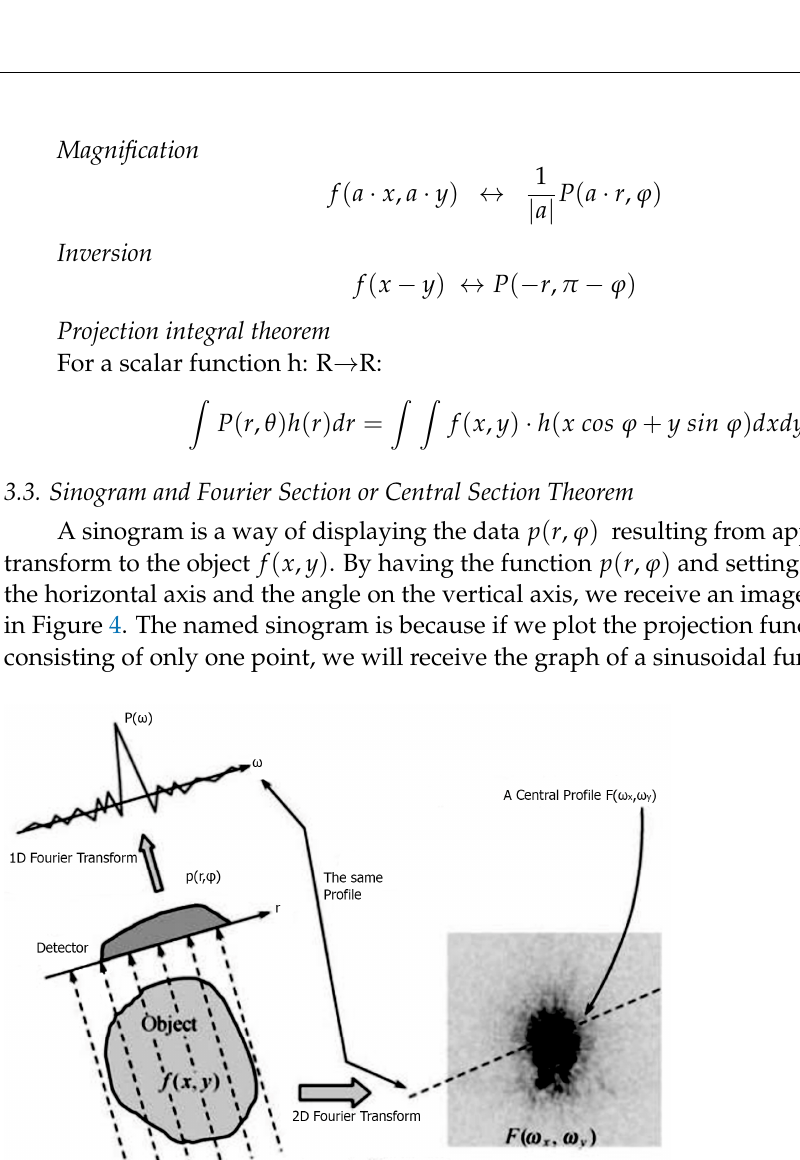
Figure 5. Image reconstruction using the Fourier intersection theorem.